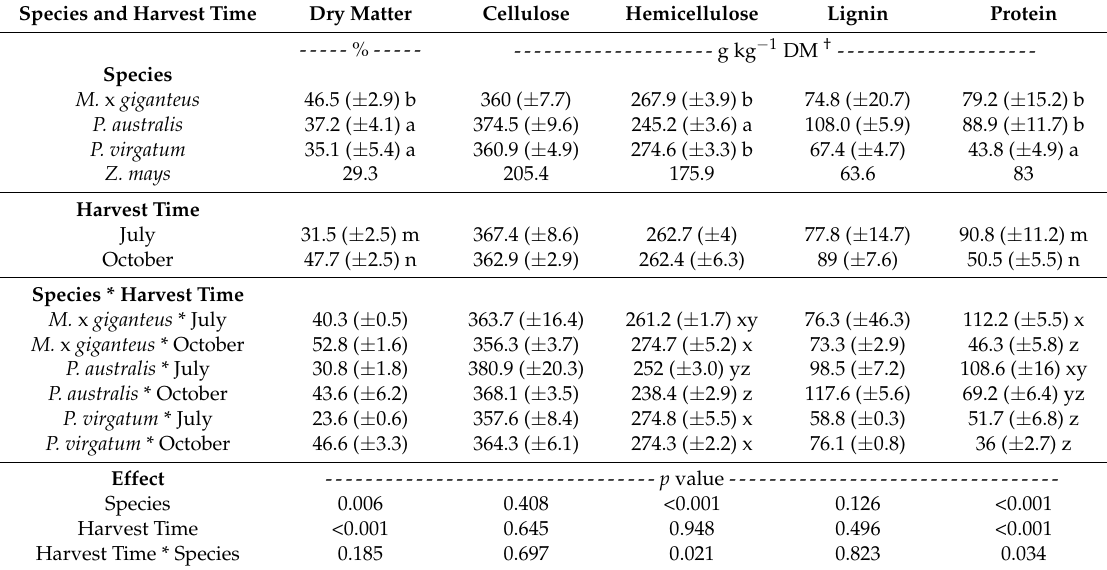
Table 2. Mean ( ± standard error) composition of 2013 samples of Phragmites australis , Panicum virgatum , and Miscanthus x giganteus ( n = 3); and Zea mays silage ( n = 1). Means followed by the same letter in each column were not significantly different according to Tukey’s range test ( p > 0.05). Zea mays was not analyzed due to lack of